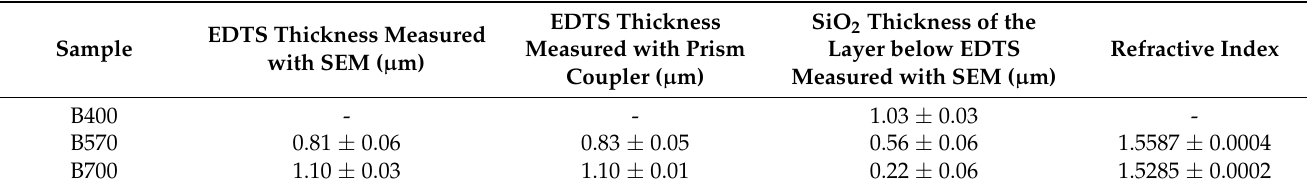
Table 1. Variation of the upper layer and remaining silica layer thickness and refractive index